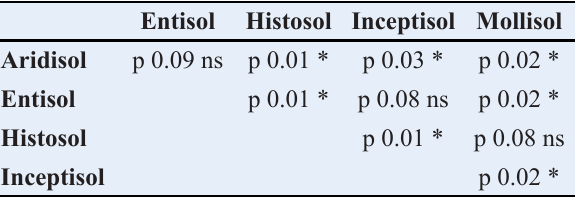
Table 3: Comparison of means of organic carbon in humic acids (HA), in the five soil orders.